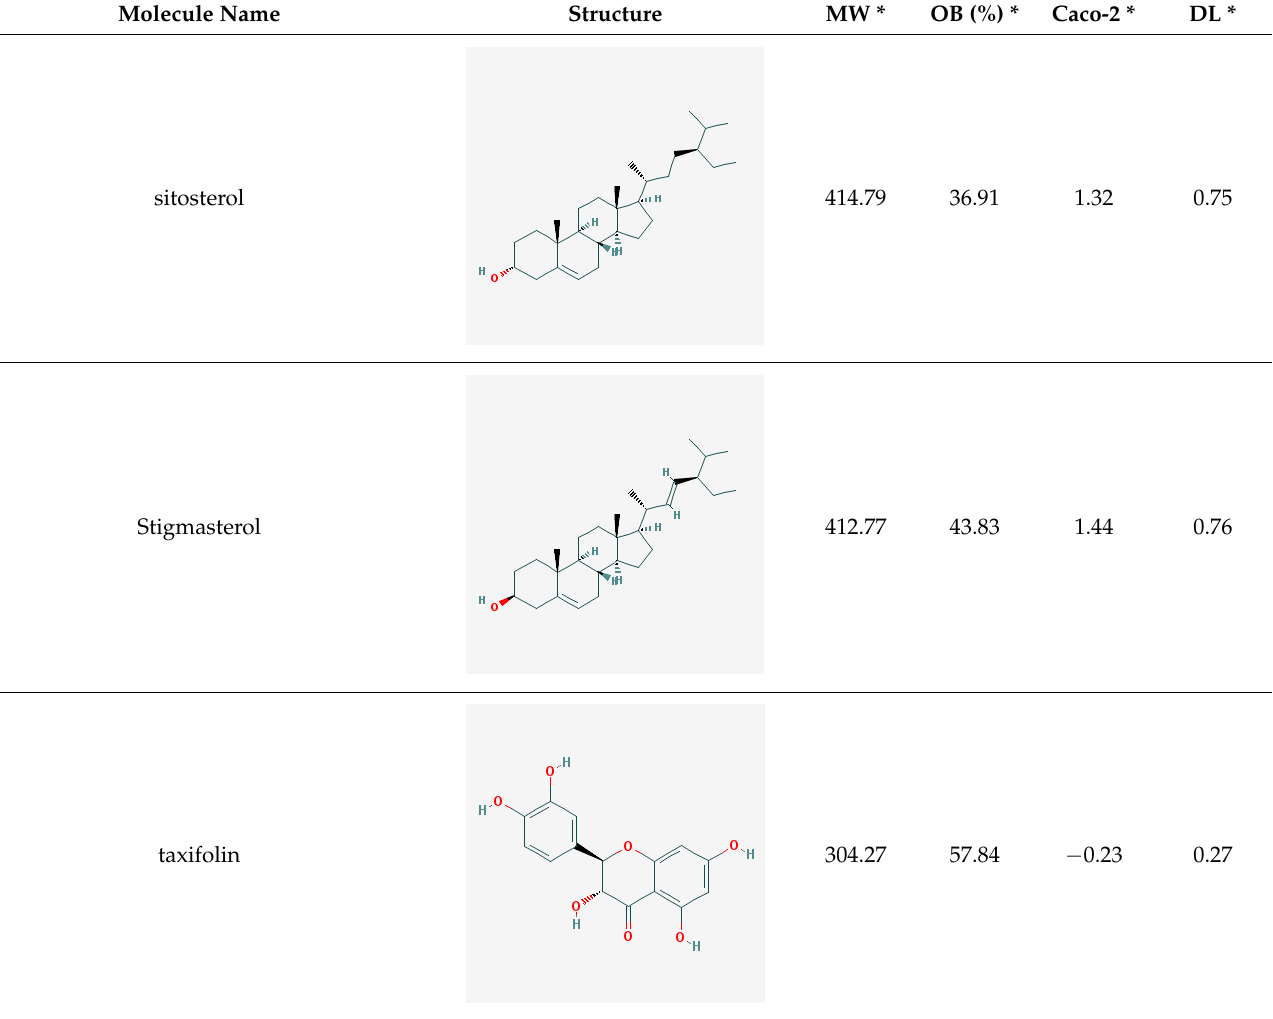
Table 2. Compounds and targets related to gastrointestinal disease.